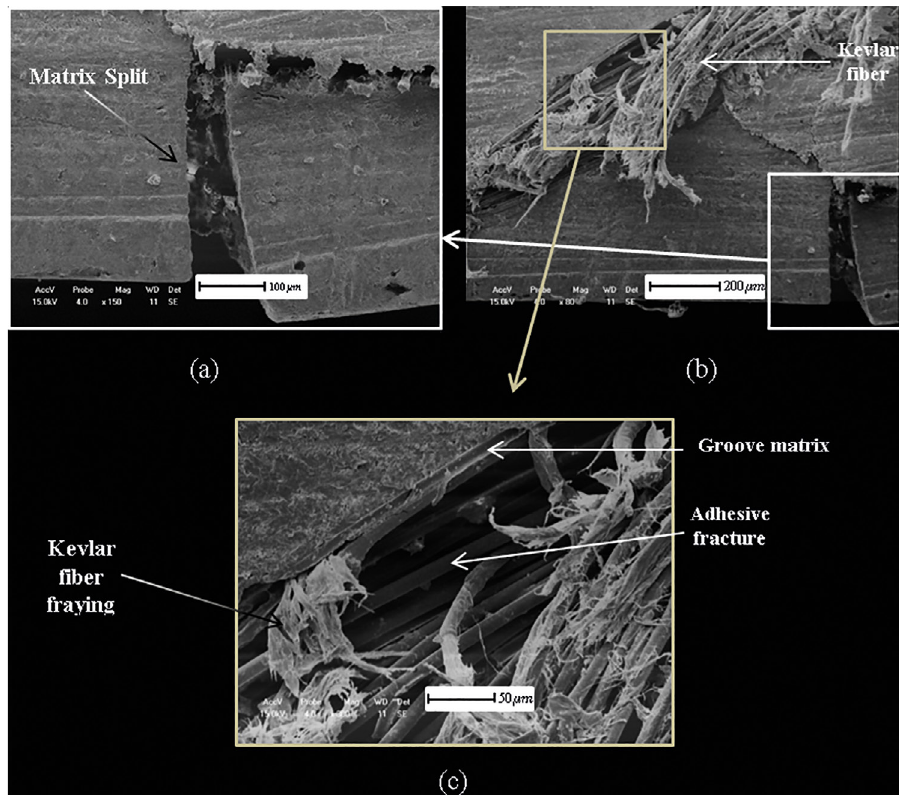
Figure 18. Fracture - HSCL laminate